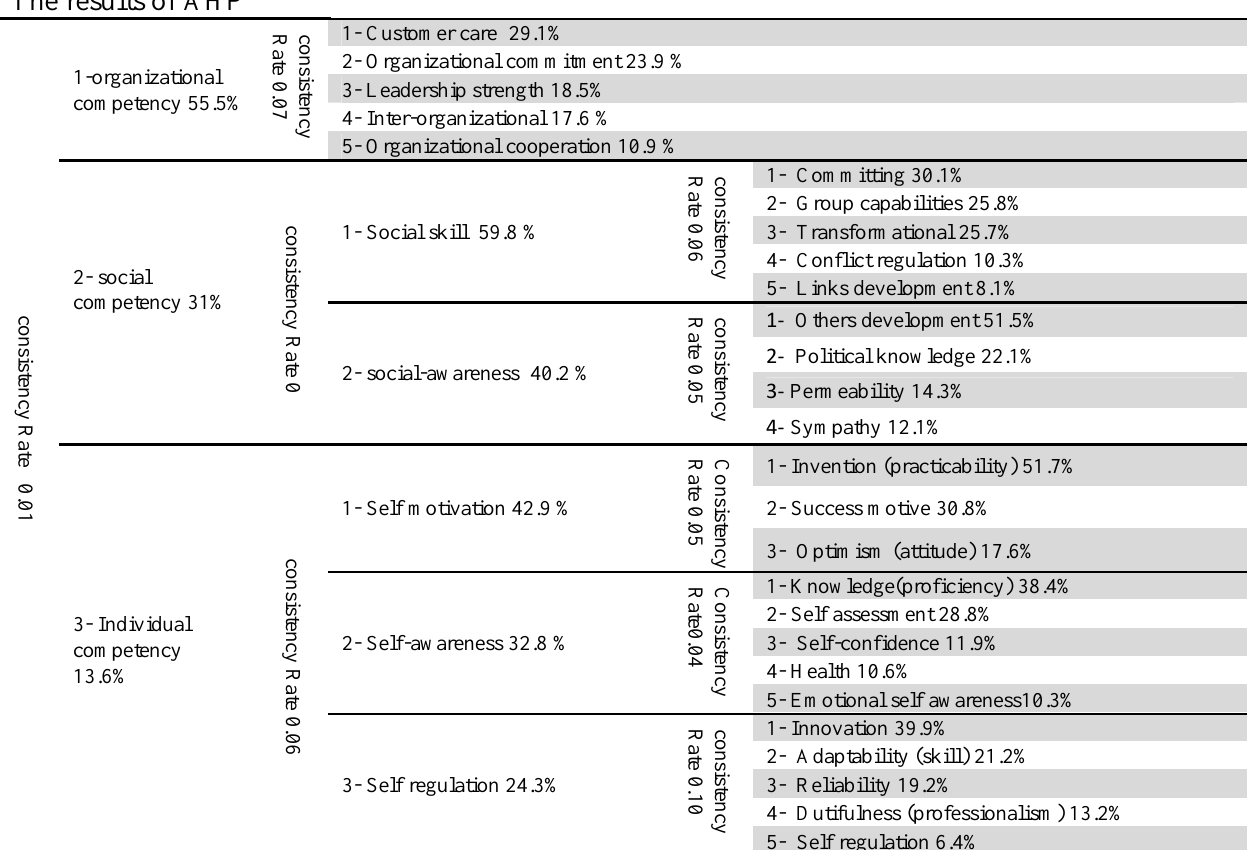
The results of AHP